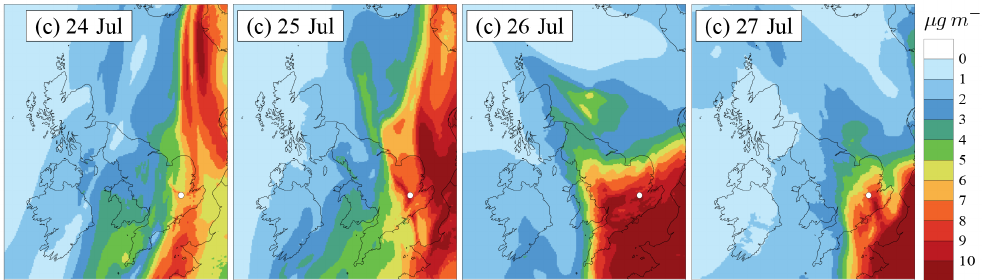
Figure 11. Modelled (addDiesel experiment) daily average concentrations of SOA during the first SOA episode of the summer 2012 IOP. The white circle indicates the location of London North Kensington.